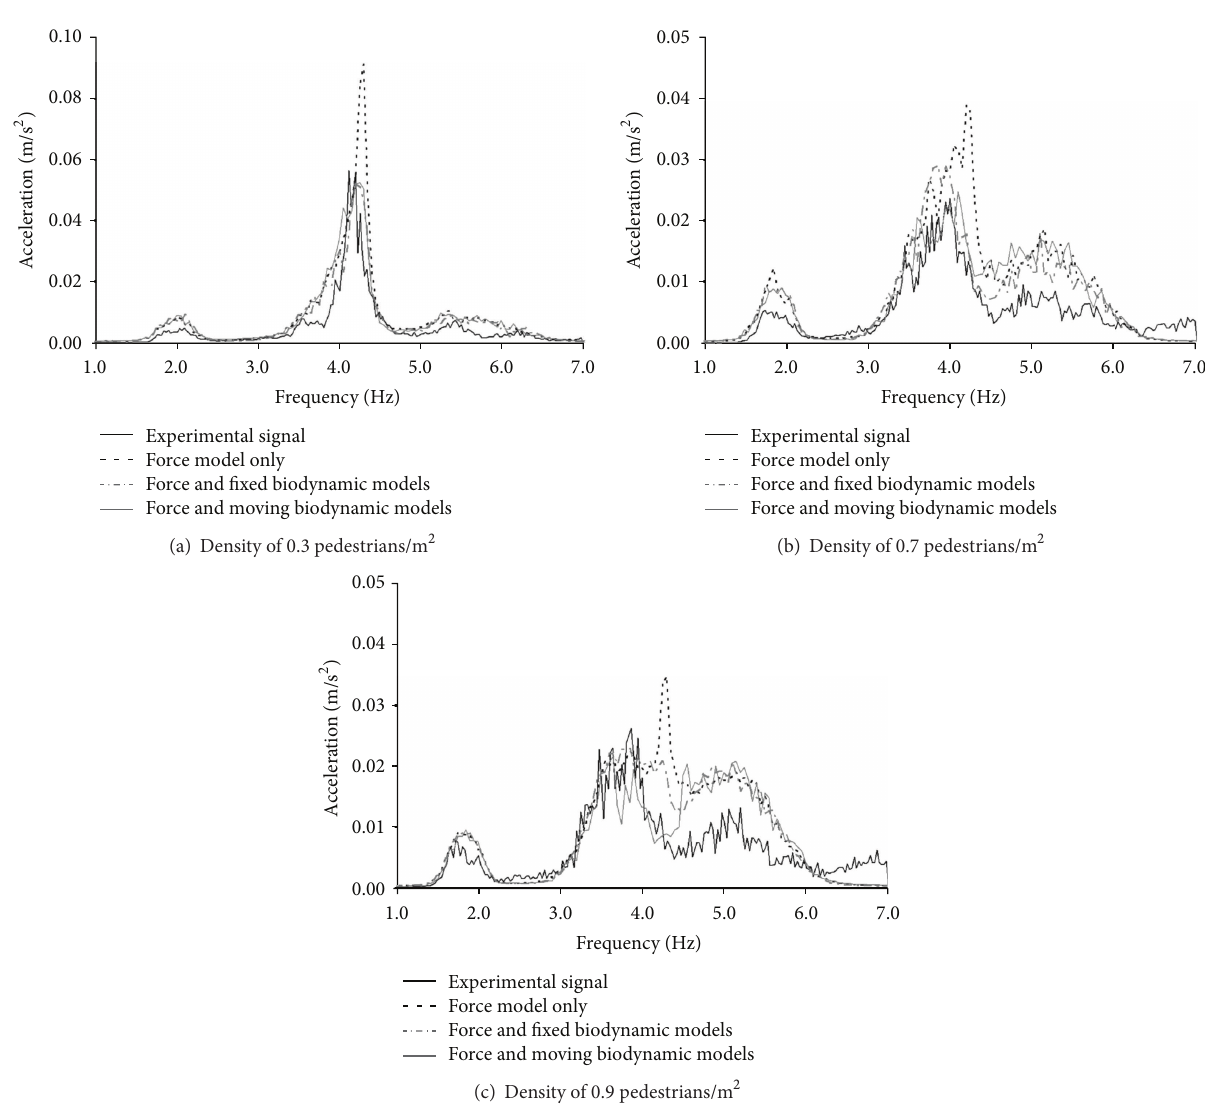
Figure 4: Mean response spectra